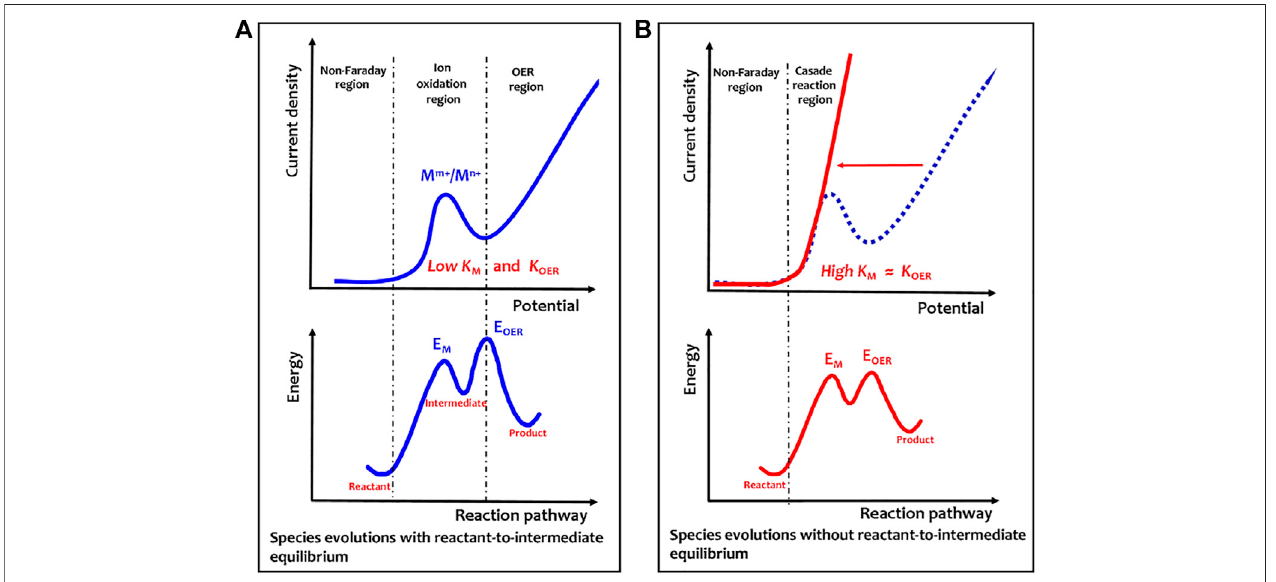
FIGURE 2 | Electricity – heat coupling mechanism of electrochemical – chemical cascaded water oxidation. (A) Anodic polarization curve of room temperature electrochemical – chemical two-step water oxidation. (B) Anodic polarization curve of heat-triggered electrochemical – chemical cascaded water oxidation. The energy pro fi le is shown here to describe energy barriers for different reaction coordinates. Evidently, in Figure 2A , much higher barrier energy for E OER than E M will induce a possible situation to establish a complete equilibrium between the reactant and intermediate. However, in Figure 2B , the two energy barriers for E OER and E M are nearlyequal, sono complete equilibrium isestablished betweenthereactantand intermediate, thus creating anearly steady-state cascade reaction from thereactant to product. Reprinted with permission from Ref.12. Copyright © 2022, American Chemical Society.